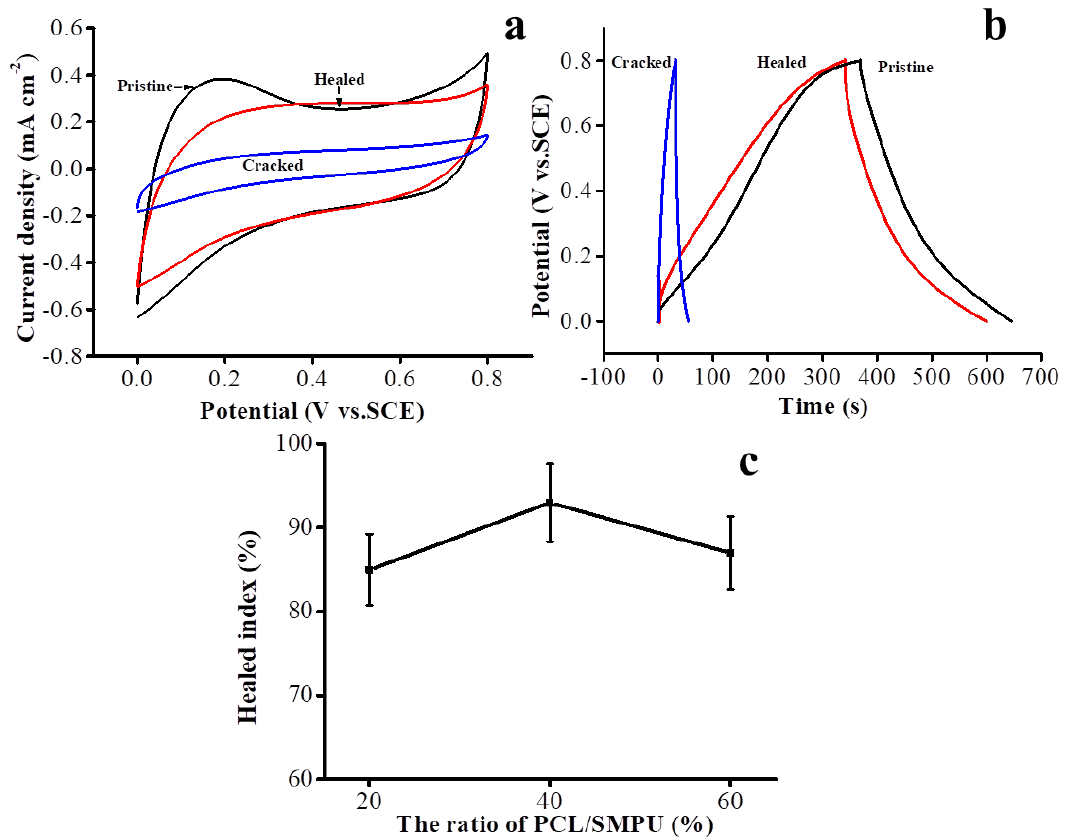
Figure 4. ( a ) CV curves of the MCP40S60 with different states collected at 5 mV s − 1 ; ( b ) galvanostatic charge/discharge curves of MCP40S60 electrode film with different states collected at 0.2 mA cm − 2 ; ( c ) healed index of the composite with different PCL contents.